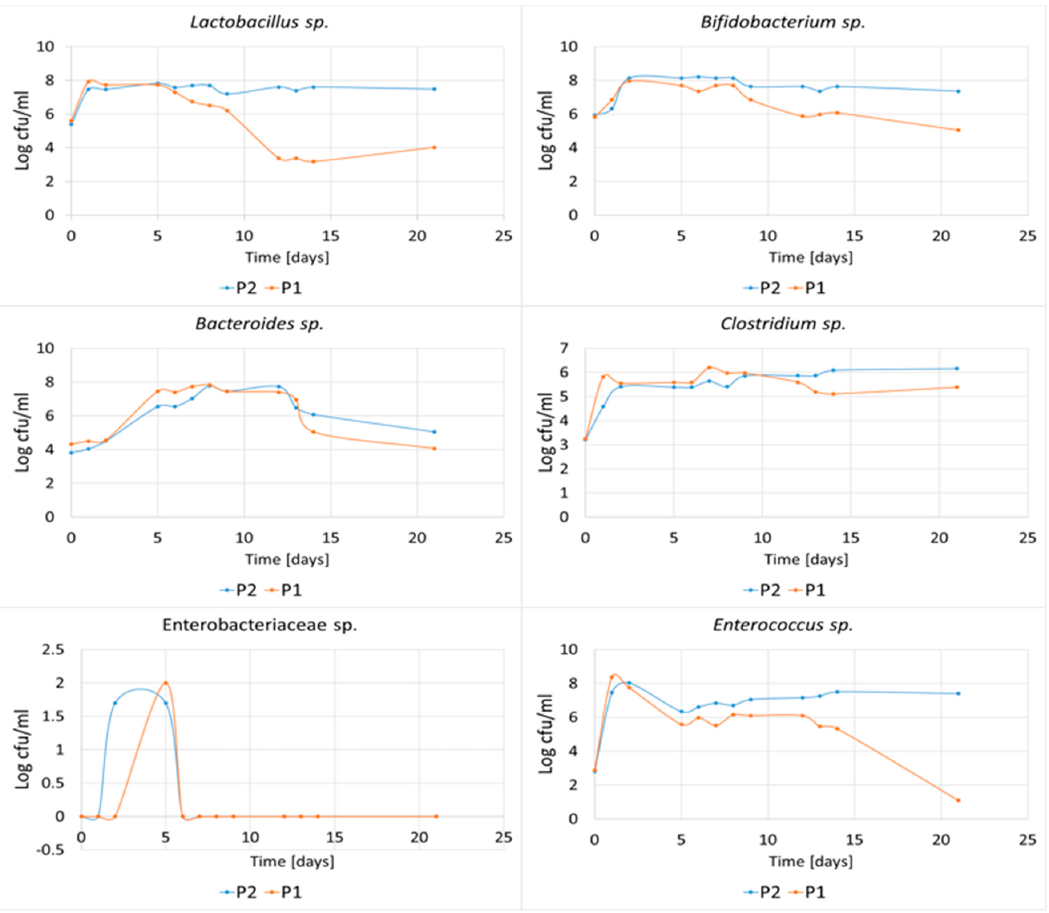
Figure 11. Dynamics of growth of Lactobacillus, Bifidobacterium, Clostridium, Bacteroides, Enterococcus and Enterobacteriaceae bacteria during in vitro fermentations in P1 and P2 hydrolysates. Data represent mean from three repeats in one experiment. Error bars denote SD.